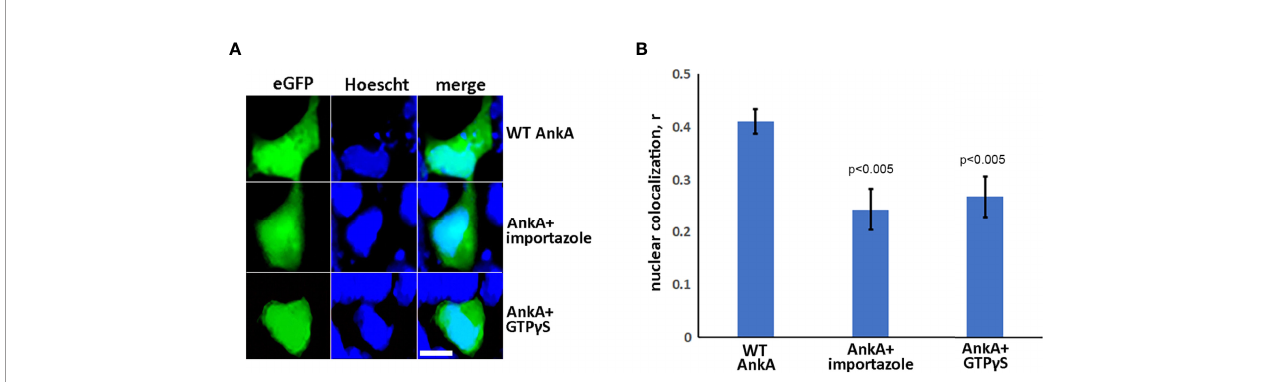
FIGURE 4 | AnkA is transported into nucleus through importin- b , RanGTP-dependent nuclear-transporting system. HEK293T cells were transfected with eGFP- AnkA plasmid constructs and treated or sham-treated with 30 µM importazole or simultaneously loaded during transfection protocol with GTP g S, a non-hydrolysable analog of GTP. After 48 hours, cells were fi xed, washed, stained with nuclear label Hoescht33342 and visualized by fl uorescence microscopy. (A) Representative images of AnkA-transfected cells in the absence or presence of importazole or GTP g S. (B) Nuclear colocalization of AnkA proteins in the presence of importazole or GTP g S relative to untreated cells. Control cells transfected with pure eGFP plasmid construct are shown. The Pearson correlation coef fi cient, r, was used for the analysis. Data are mean ± SEM of 30-40 randomly selected ROIs containing 100-200 transfected cells of two independent experiments in duplicate. Student t-test p values compared to wild type AnkA are shown. Bar-